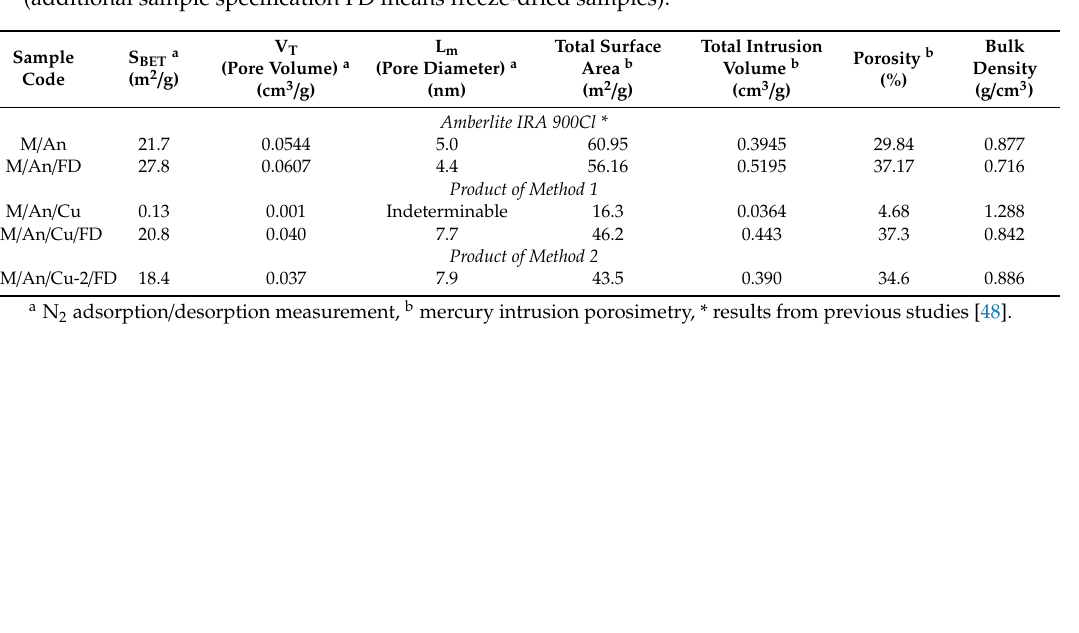
Table 5. Porous characteristics of supporting anion exchanger and Cu 0 -doped anion exchanger (additional sample specification FD means freeze-dried